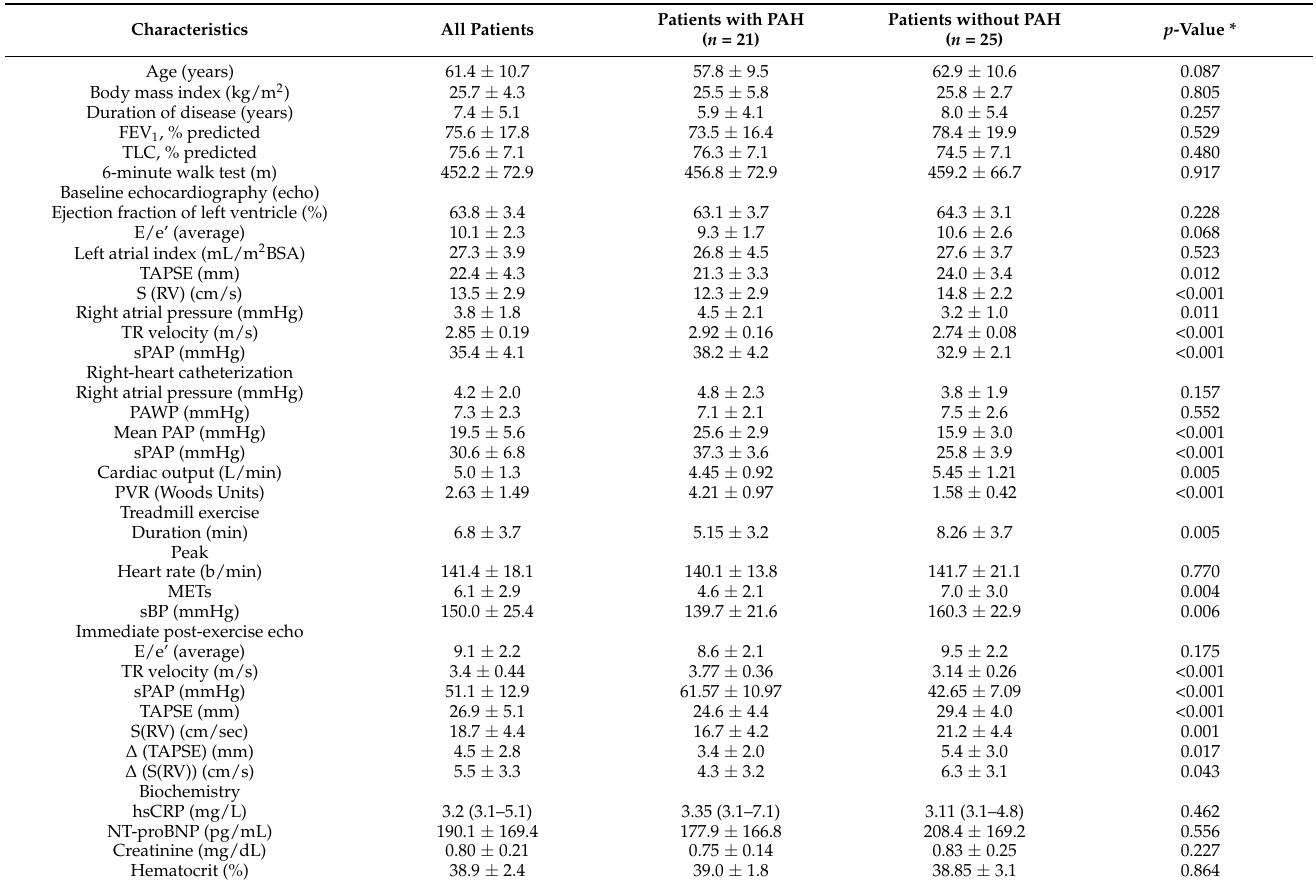
Table 1. Characteristics of patients with systemic sclerosis according to the presence of pulmonary arterial hyperten- sion (PAH).